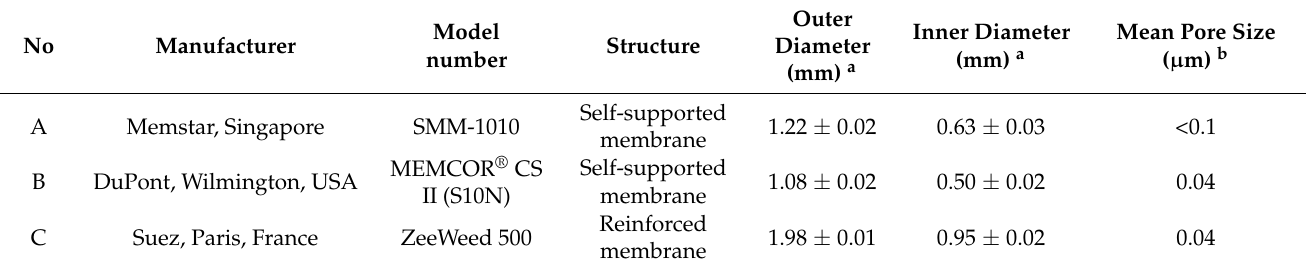
Table 1. The Characteristics of the commercial hollow fiber UF